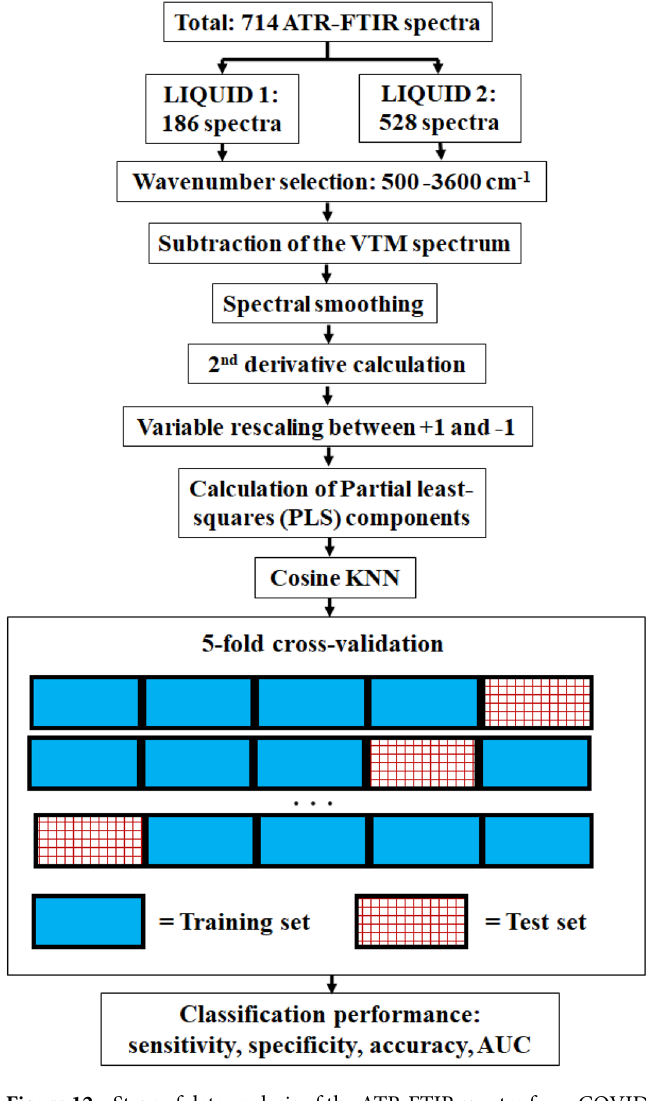
Figure 12. Steps of data analysis of the ATR-FTIR spectra from COVID-19 VTM LIQUID